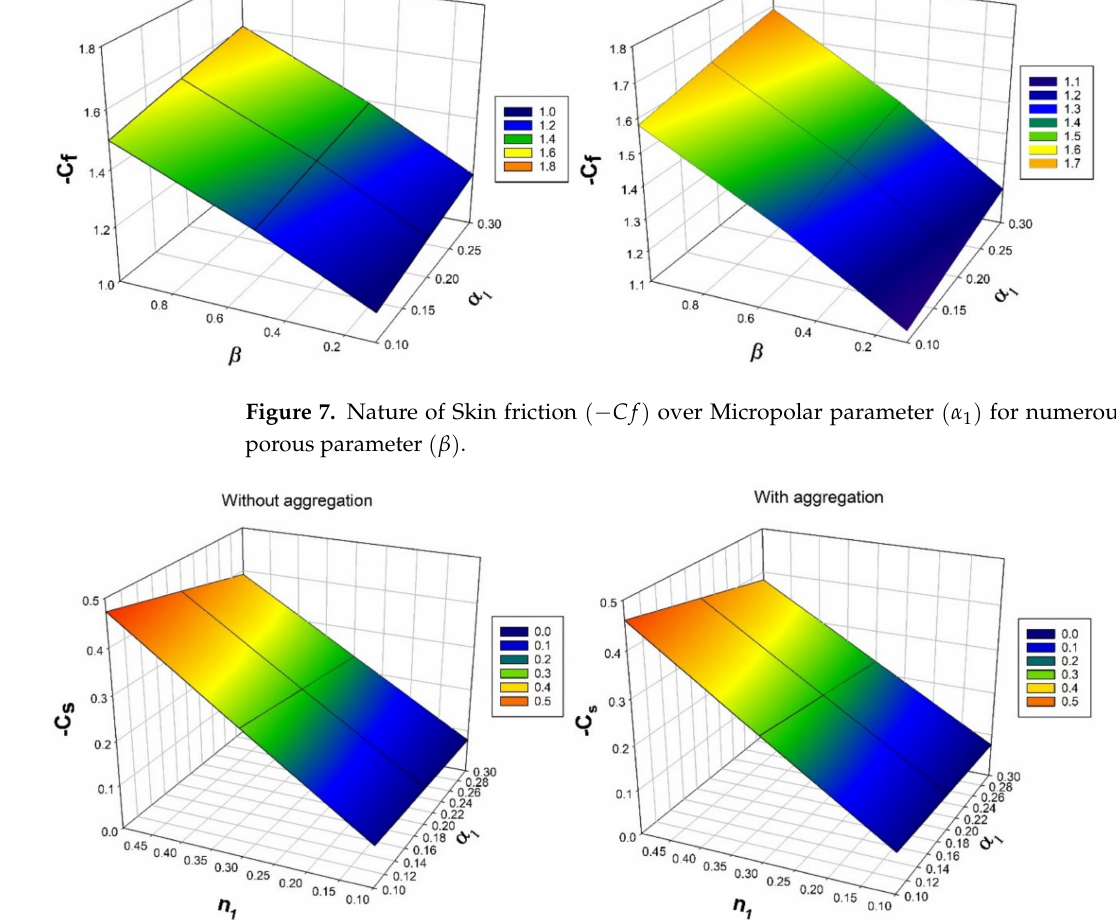
Figure 8. Nature of wall couple stress factor ( − Cs ) over Micropolar parameter ( α 1 ) for numerous values ofmicrorotation parameter ( n 1 ) .